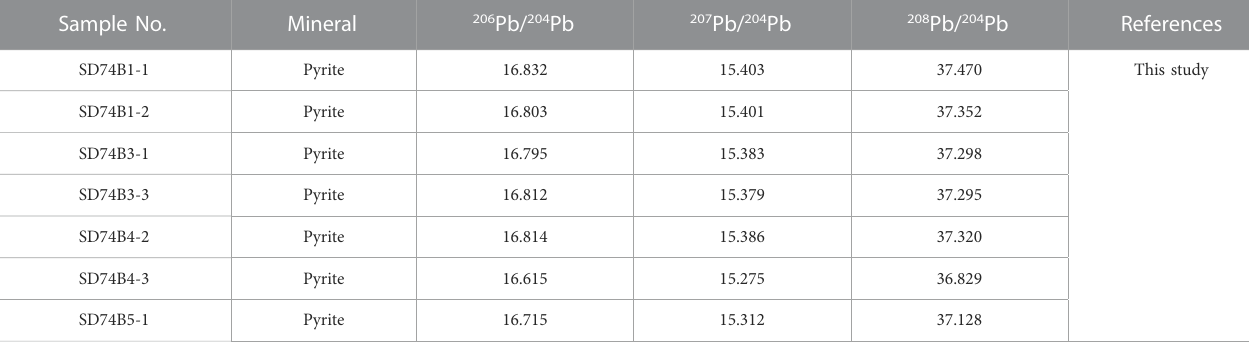
TABLE 3 Lead isotopic compositions of pyrites from the Yangjiakuang gold deposit. Sample